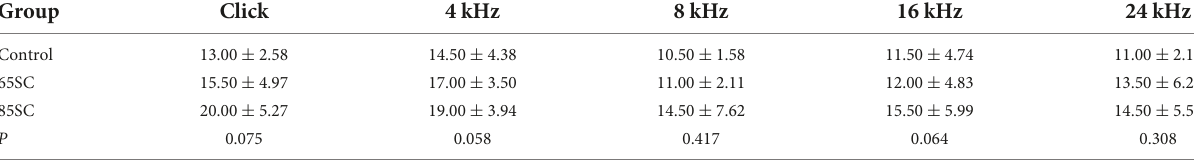
TABLE 1 Auditory brainstem response (ABR) thresholds for each group at the end of the sound conditioning (dB SPL).